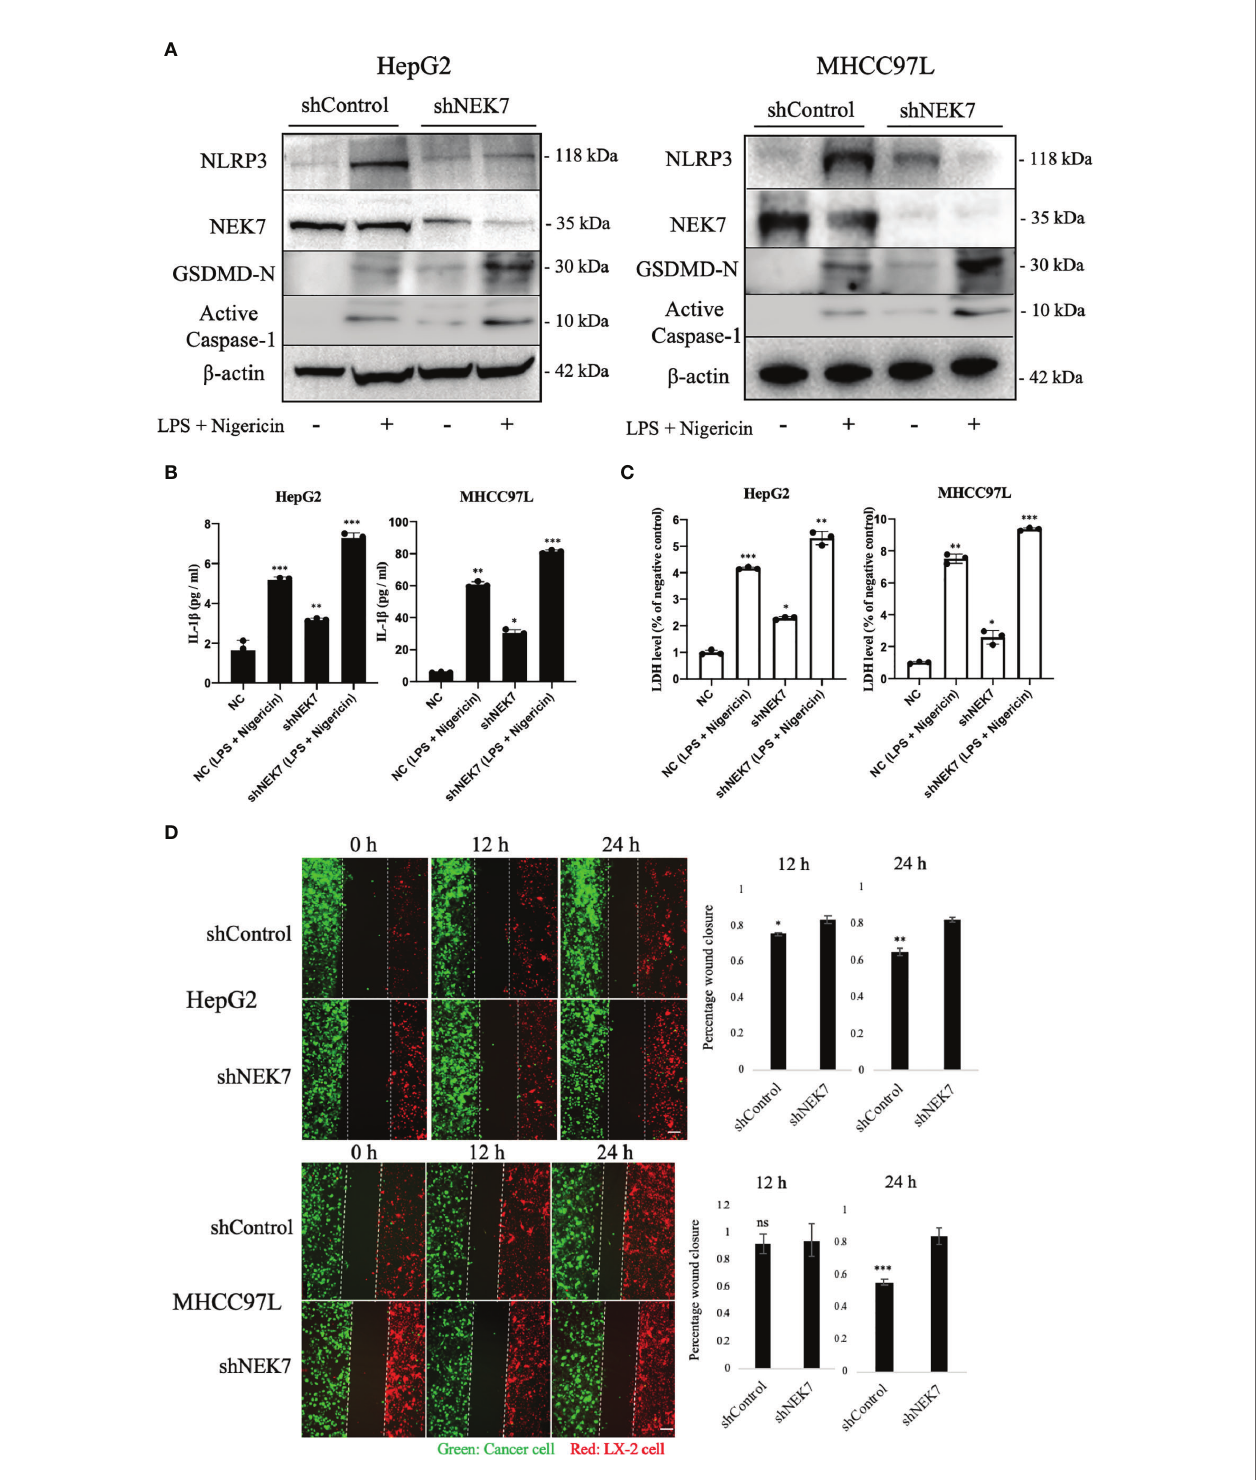
FIGURE 4 | NEK7 regulated HCC pyroptosis and inhibited its migratory toward HSC. (A) Protein levels of NLRP3, GSDMD, NEK7, and Cleaved caspase-1 in HCCs transfected with shRNAs targeting NEK7 or negative control. LPS and nigericin treatment was positive control for cell pyroptosis. (B) IL-1 b release of HCC supernatant. (C) LDH release of HCC supernatant. (D) shControl or shNEK7 cells were dyed with CellTracker Green, LX-2 cells were dyed with CellTracker Red, and migration was performed for 12 and 24 h. Original magni fi cation: ×100. Scale bars = 100 m m. *p < 0.05, **p < 0.01, ***p <